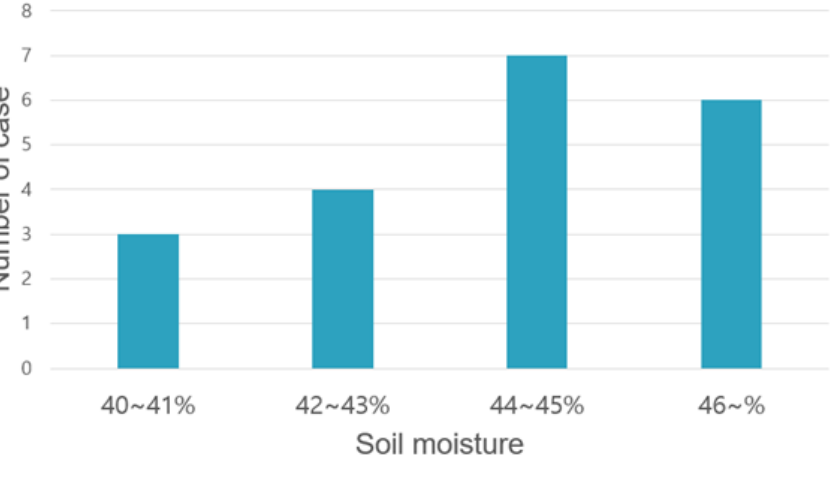
Figure 19. Case distribution according to max soil moisture in cloud level closed-loop control.